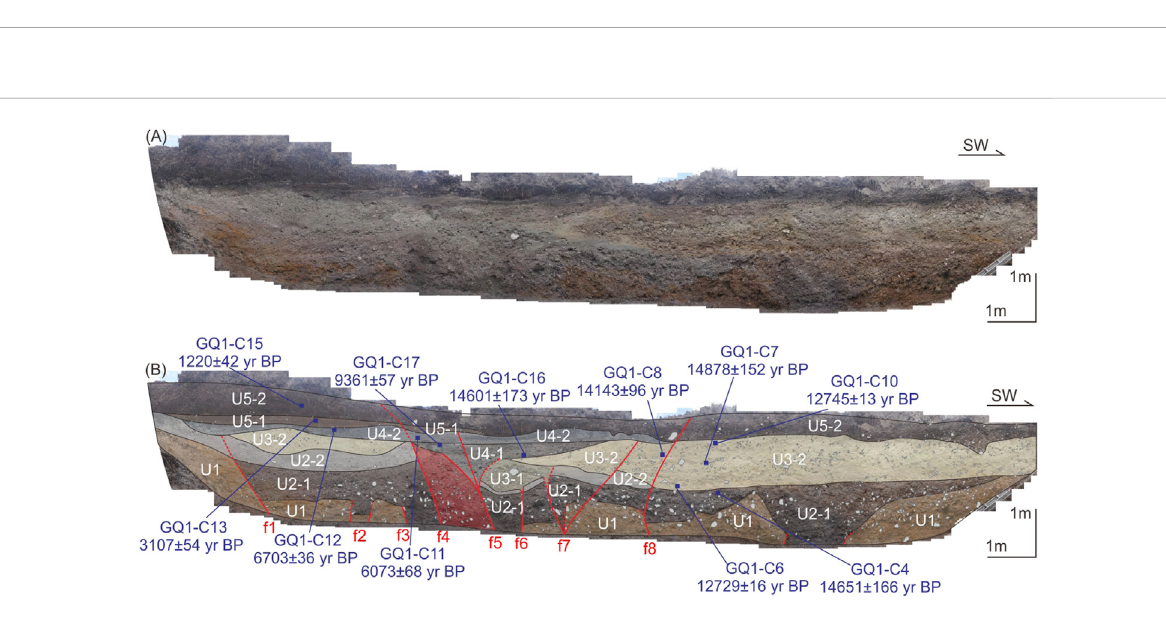
FIGURE 6 Faulted landforms around the trench GQ2 excavation site. (A) The hillshade map is generated from an unmanned aerial vehicle-based digital elevation model. The location is shown in Figure 3A. The red arrows point to the surface trace of the fault. (B) P topographic pro fi le across the fault scarp. (C,D) Field photos of the fault scarp and location of trench GQ2.